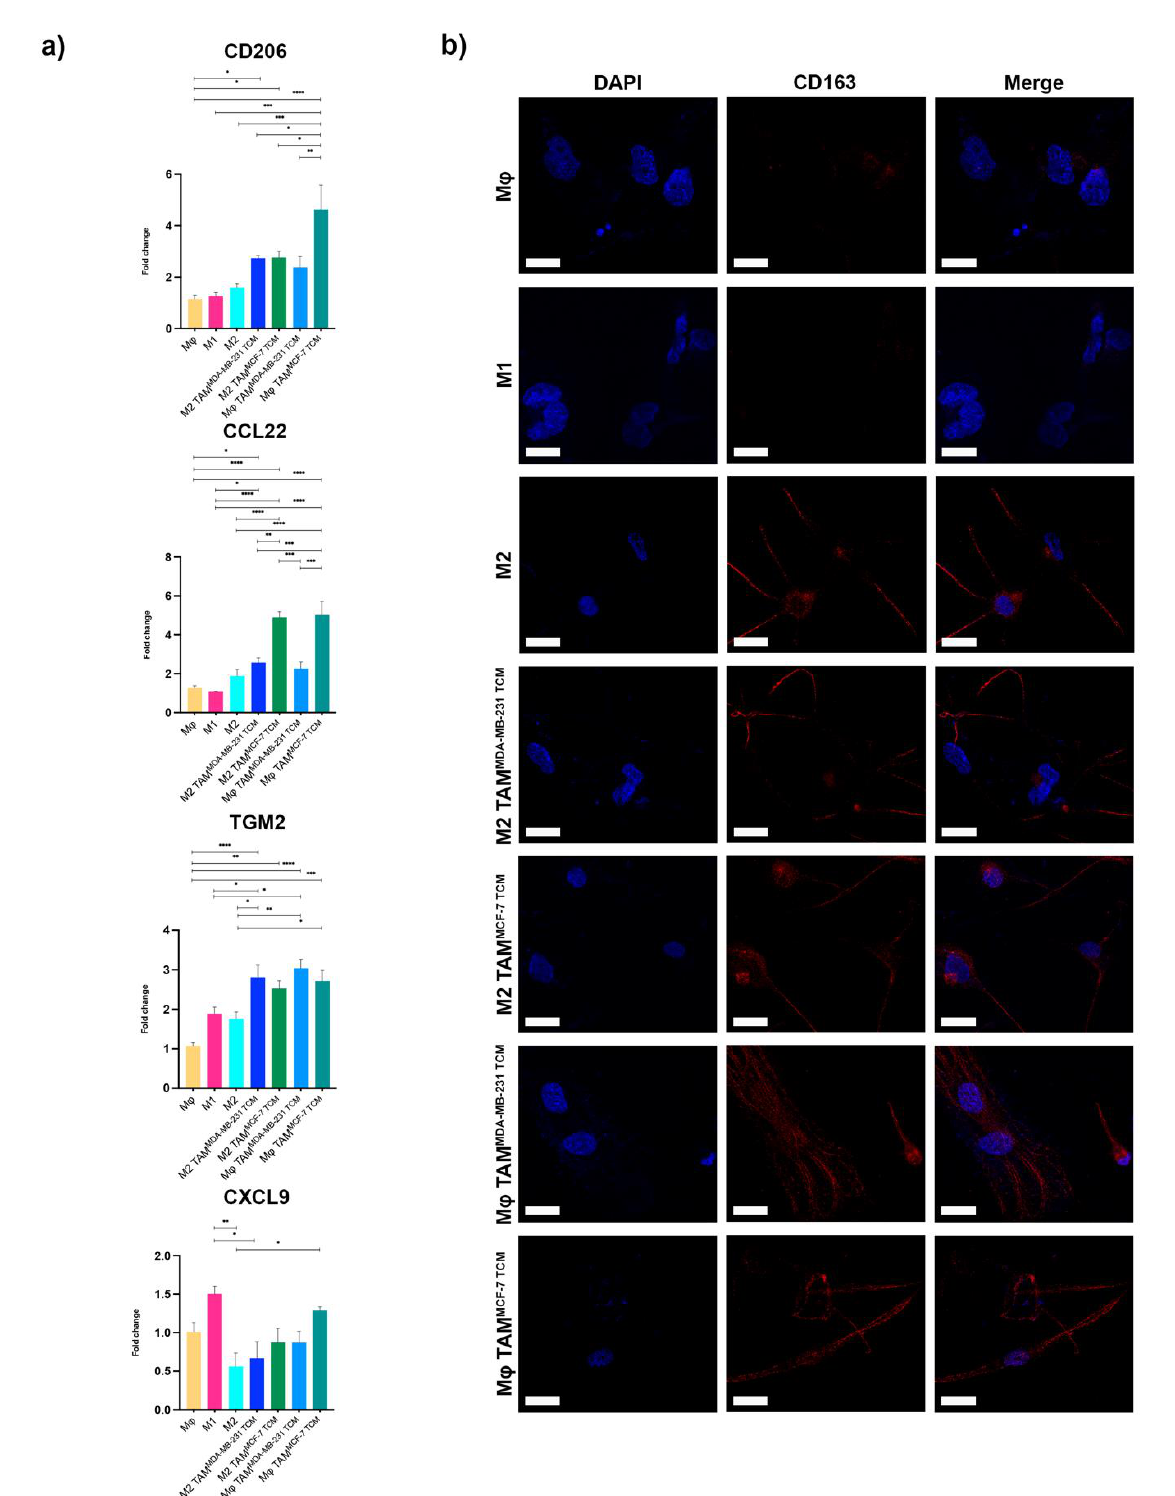
Figure 2. Macrophage marker expression. ( a ) Gene expression analysis of M2-markers evaluated by qRT-PCR. Error bars represent ± SEM. One-way ANOVA and Tukey correction was used to evaluate the differences between means; * p < 0.033, ** p < 0.002, *** p < 0.0002, **** p < 0.0001. n = 4 for each experimental group. ( b ) Immunofluorescence analysis of the surface marker CD163 showing CD163 + macrophages in red. M ϕ untreated macrophages and M1-polarized macrophages with LPS were used as negative controls. Nuclei were counterstained with DAPI. Scale bars represent 40 µm.